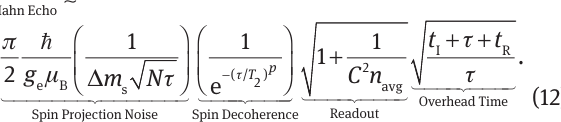
. Counts per readout are for an assumed readout time of 300 ns. Assumed NV−